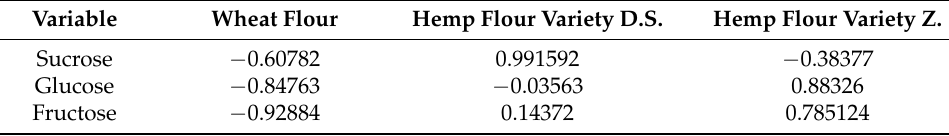
Table 10. Pearson correlation for carbohydrate of flour sample. Variable Wheat Flour Hemp Flour Variety D.S. Hemp Flour Variety